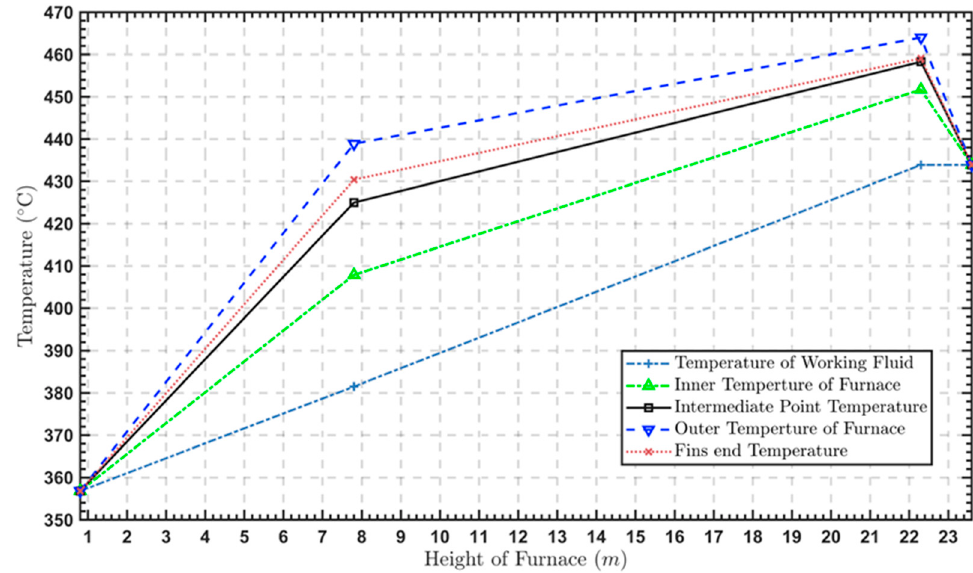
at the fin end is 459.1 ◦ C.